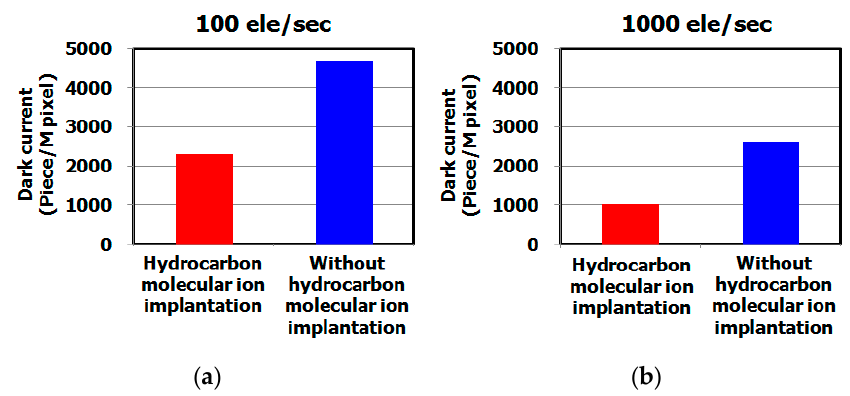
Figure 8. Histograms of dark current level after CMOS image sensor fabrication process on epitaxial silicon wafers with and without hydrocarbon–molecular–ion implantation. The dark current levels were measured by dark current spectroscopy under 60 °C. The epitaxial thickness is 7 μ m and hydrocarbon–molecular–ion dose amount is 1 × 10 15 cm − 2 . ( a ) Number of middle range in white spot level with and without hydrocarbon–molecular–ion implantation, ( b ) Number of large range in white spot level with and without hydrocarbon–molecular–ion implantation.